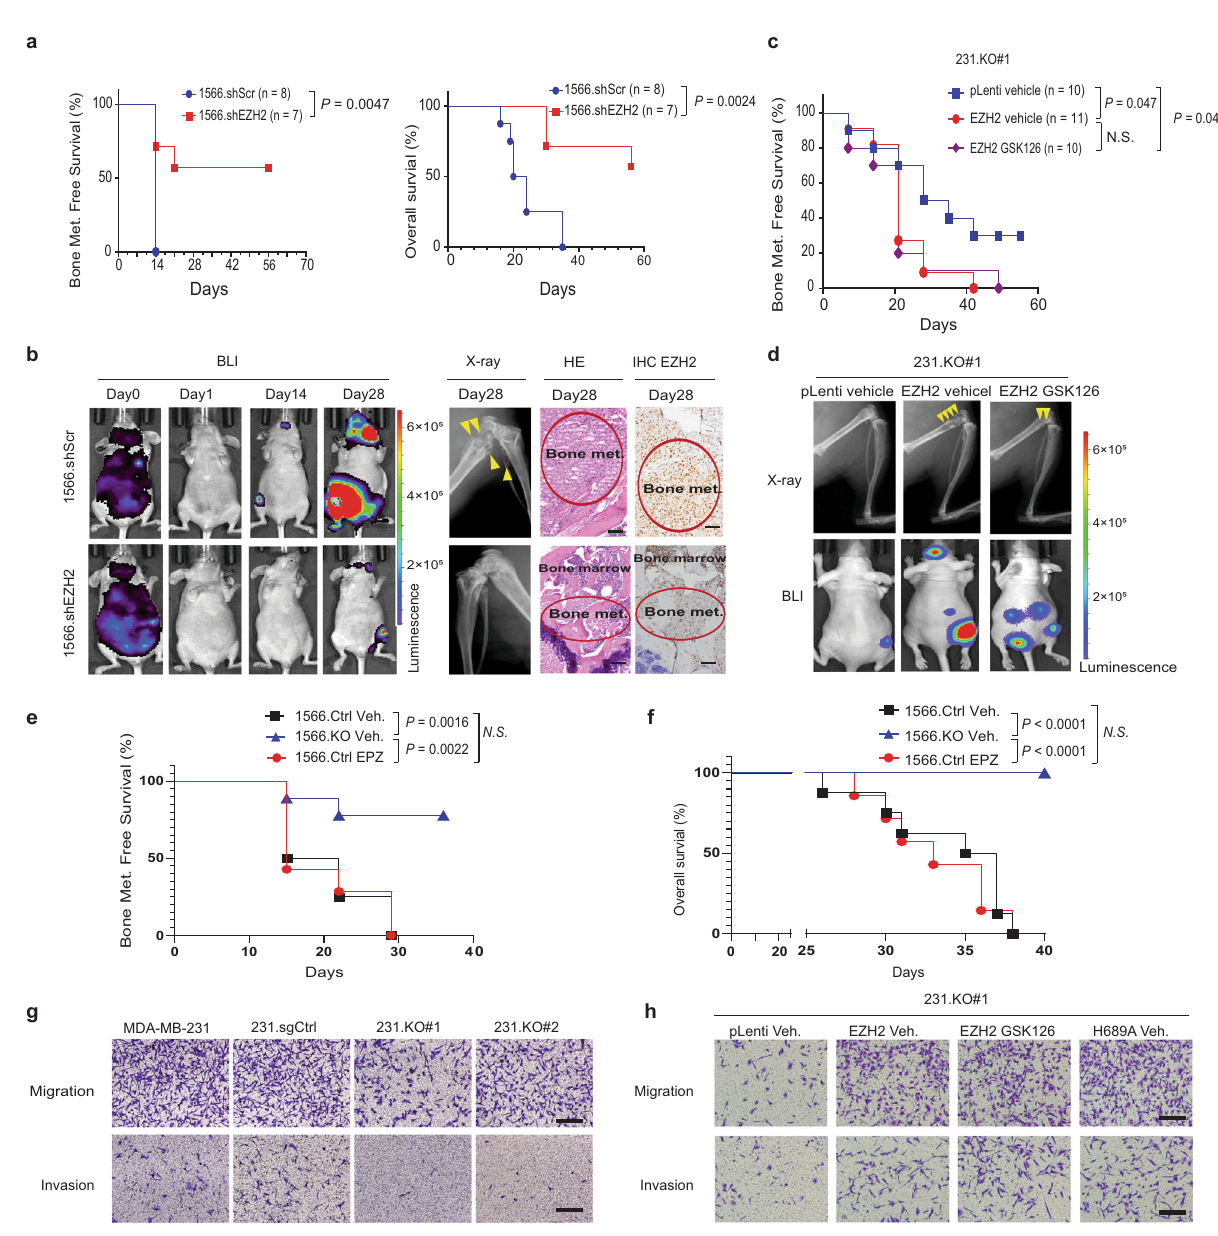
Fig. 1 EZH2 promotes breast cancer bone metastasis, which cannot be blocked by an EZH2 methyltransferase inhibitor. a Kaplan – Meier curves showing bone metastasis-free survival and overall survival rates in mice intracardially injected with 1 × 10 5 1566.shCtrl ( n = 8) or 1566.shEZH2 ( n = 7) cells. Log-rank test. b Representative bioluminescence (BLI), X-ray, and hematoxylin and eosin (HE)-stained images of bone-metastatic lesions in the 2 subgroups described in ( a ) obtained at the indicated time points. The arrows indicate osteolytic bone lesions in X-ray images. EZH2 expression is shown by IHC staining. Scale bars, 50 μ m. c Kaplan – -Meier curves showing bone metastasis-free survival rates in mice intracardially injected with 1 ×10 5 231.KO#1.pLenti cells and given treatment with a vehicle (231.KO#1.pLenti vehicle , n = 10) or 1× 10 5 231.KO#1.EZH2 cells and given treatment with a vehicle (231.KO#1.EZH2 vehicle , n = 11) or GSK126 (231.KO#1.EZH2 GSK126; n = 10; 150 mg/kg GSK126 per mouse, i.p. injection three times a week). Log-rank test. d Representative X-ray and bioluminescence (BLI) images of bone-metastatic lesions in the three subgroups described in c . The arrows indicate osteolytic bone lesions in X-ray images. e , f Kaplan – Meier survival analysis showing bone metastasis-free survival ( e ) and overall ( f ) survival rates in nude mice intracardially injected with luciferase-labeled 1 × 10 5 1566.Ctrl and treated with vehicle ( n = 8) or EPZ6438 ( n = 7), or injected with 1566.KO cells and treated with vehicle ( n = 9). Log-rank test. g Representative images of invading and migrating MDA-MB-231, 231.sgCtrl., 231.KO#1, and 231.KO#2 cells. Scale bars, 100 μ m. h Representative images of invading and migrating 231.KO#1.pLenti. cells treated with vehicle, 231.KO#1.EZH2 cells treated with vehicle, 231.KO#1.EZH2 cells treated with 2 μ M GSK126, and 231.KO#1.H689A cells treated with vehicle. Scale bars, 100 μ m. All P values are indicated in the fi gures. (Supplementary Fig. 1g, h). The above loss- and gain-of EZH2 To explore the mechanism of EZH2 promotion of bone function in vivo bone metastasis experiments demonstrated metastasis, we fi rst compared the proliferation, migration, and that EZH2 promoted breast cancer bone metastasis and that invasion ability of high and low EZH2-expressing MDA-MB-231 EZH2 ’ s effect on bone metastasis is likely methyltransferase- cell sublines. High EZH2-expressing cells (MDA-MB-231 and independent. 231.sgCtrl) and low EZH2-expressing cells (231.KO #1 and #2) NATURE COMMUNICATIONS| (2022) 13:2543